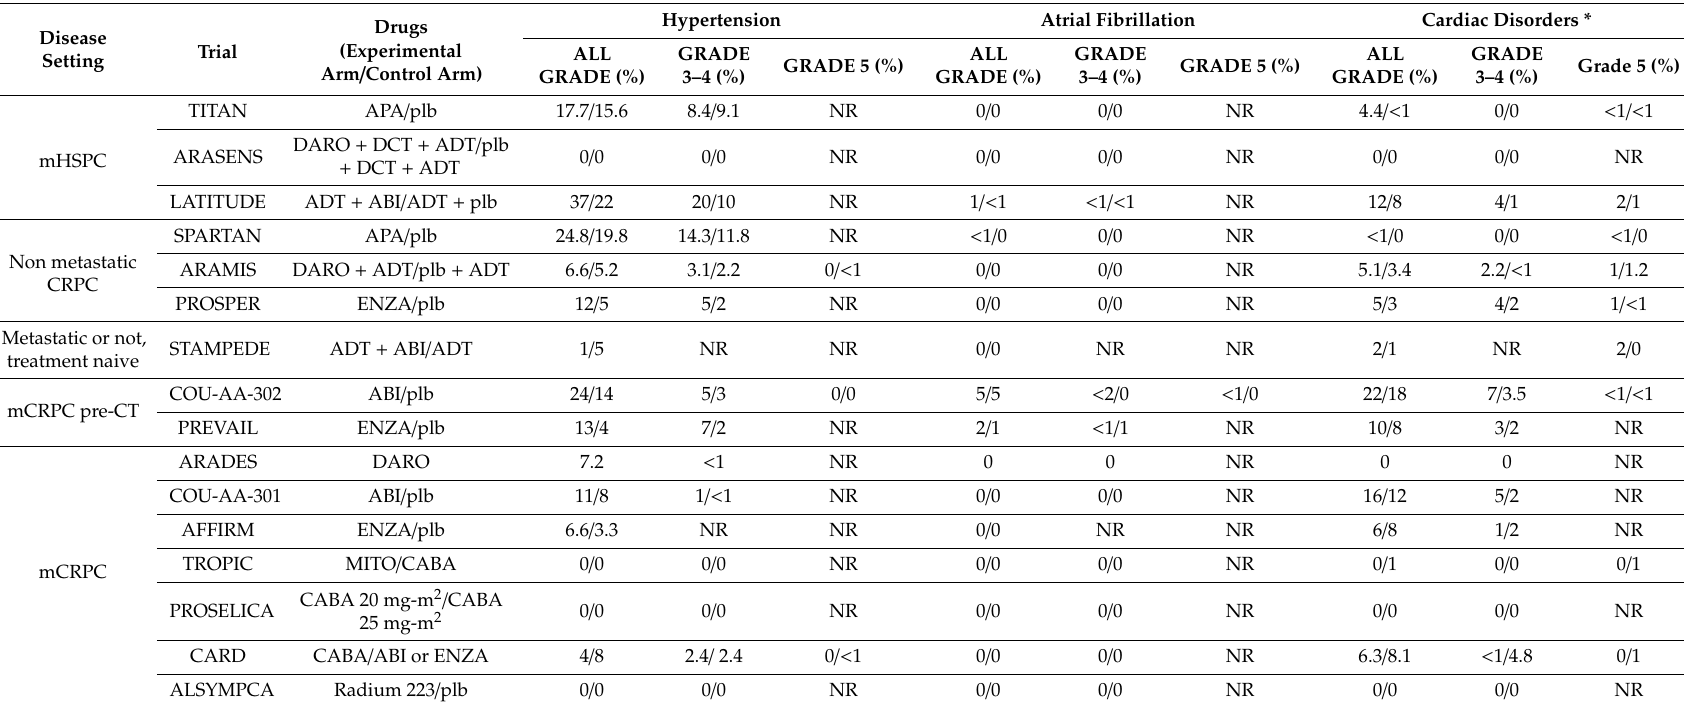
Table 2. Incidence of cardiovascular adverse events of new drugs for advance prostate cancer